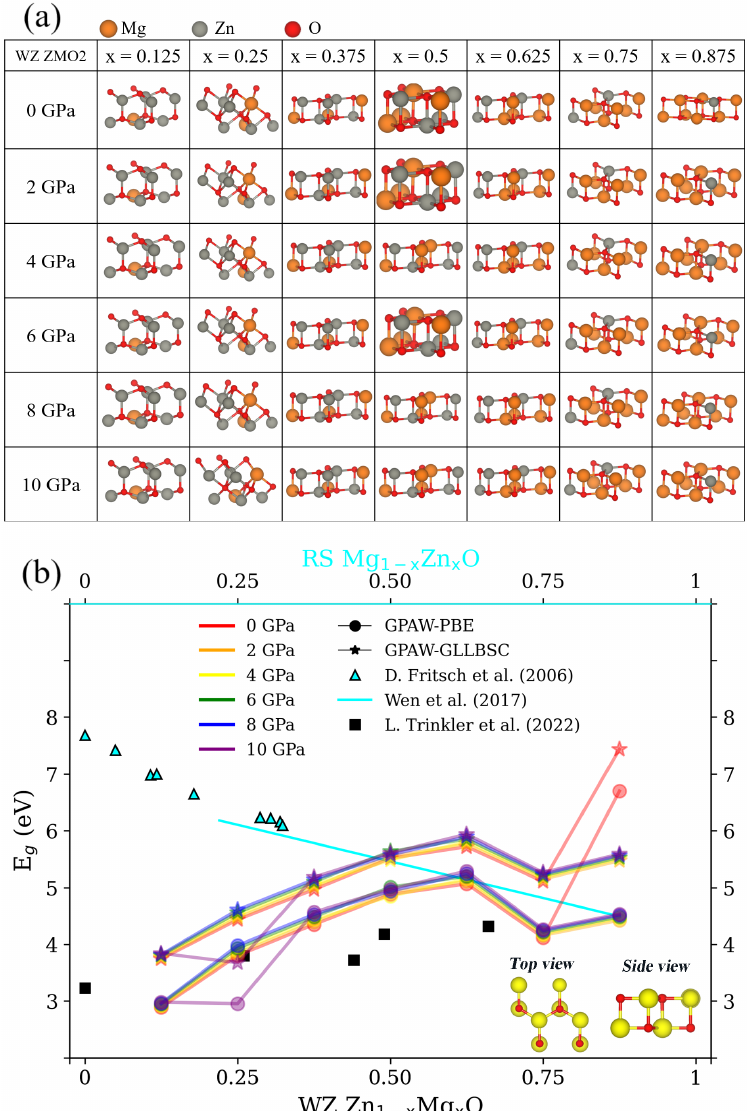
Figure 4. ( a ) Optimized structures and band gap ( E g ) of wurtzite (WZ) Zn 1 − x Mg x for the WZ ZMO2 model in Figure 1 with x = 0.125, 0.25, 0.375, 0.5, 0.625, 0.75 and 0.875, as well as the pressures from 0 GPa to 10 GPa in 2 GPa increments. The symbols, colors and legends of Subfigure ( a , b ) are identical to the descriptions in Figure 3a,b, respectively. The insets of Subfigure ( b ) are the top and side views of the structures of x = 0.75 and 0.875 in Subfigure ( a ), except for the structure of x = 0.875 within 0 GPa. The yellow spheres are either magnesium (Mg) or zinc (Zn); the red spheres represent oxygen. The E g detailed in Appendix A of Table A3 corresponds to the values in Subfigure ( b )